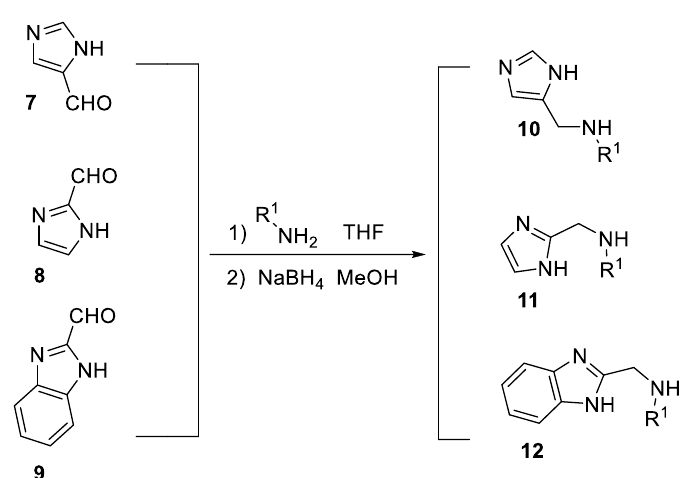
Scheme 2. Synthesis of imidazole N -substituted methanamines.